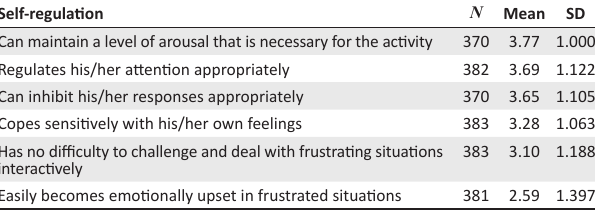
TABLE 1: Descriptive statistics of the self-regulation